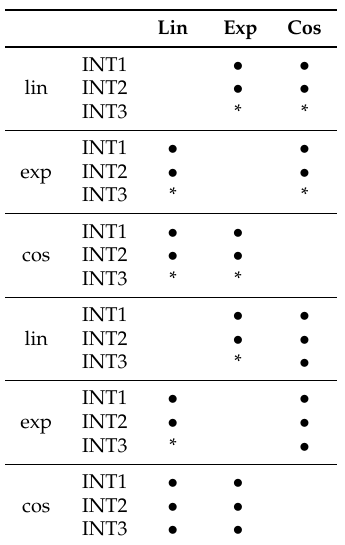
Table 10. Interpretation for the results of the pairwise t-test with Bonferonni correction, in terms of the different parametrization profiles, using GA as the optimization algorithm (a) and DE (b). The positive results are marked as an asterisk (*), and the negative with a dot ( •